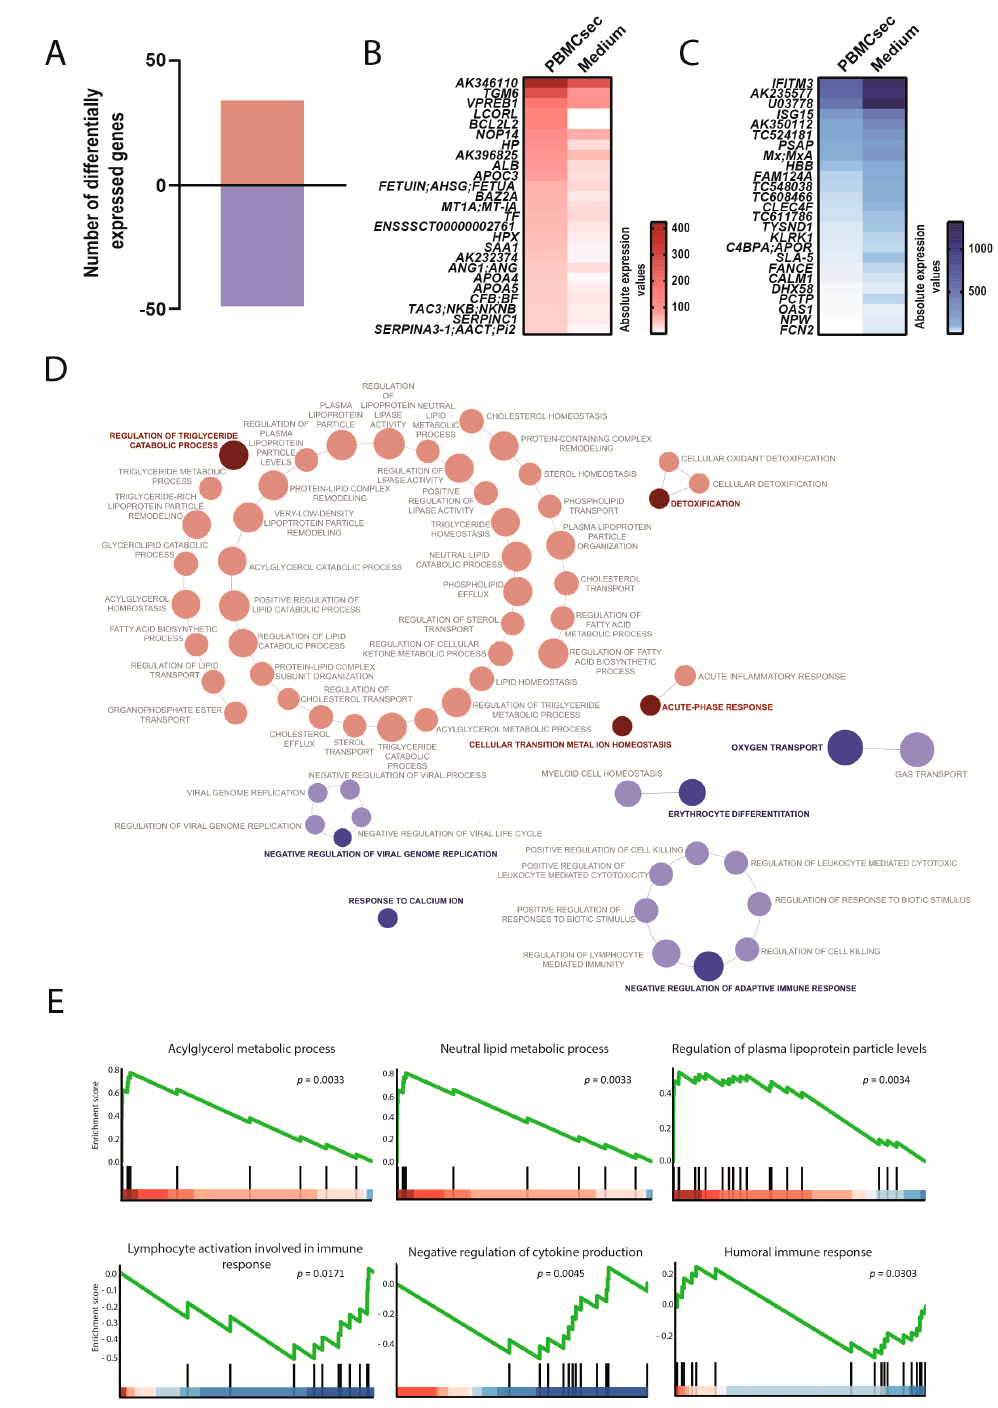
Figure 7. Transcriptional changes induced by the PBMCsec in the spleen. ( A ) Total numbers of differentially expressed genes. Red and blue indicate up- and downregulated genes, respectively, when comparing the PBMCsec versus the medium. The average fold change of n = 6 animals per group is shown. Absolute expression values of genes ( B ) up- and ( C ) downregulated by the PBMCsec compared with the medium. Colors indicate expression values. ( D ) GO terms associated with up- (red) and downregulated (blue) genes. Each circle represents one term. Circle sizes indicate p -values. Overarching terms within a group are highlighted in bold. ( E ) GSEA of up- (upper panel) and downregulated (lower panel) genes by the